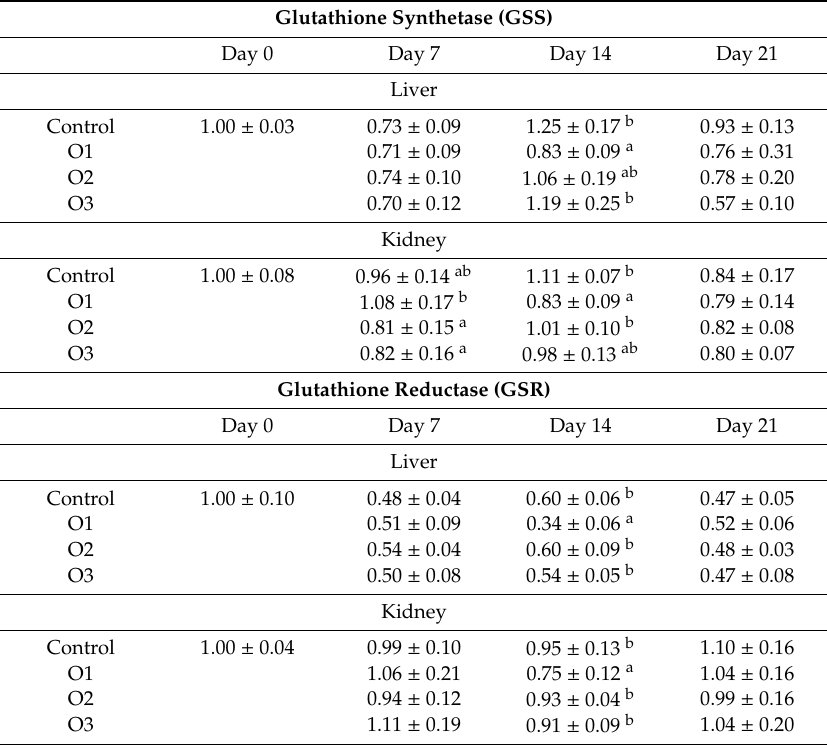
Table 9. E ff ect of Ochratoxin A treatment on the relative expression of GSS and GSR genes in the liver and kidney of broiler chickens (mean ± SD; n = 6 in a pool, equal amounts of cDNA per